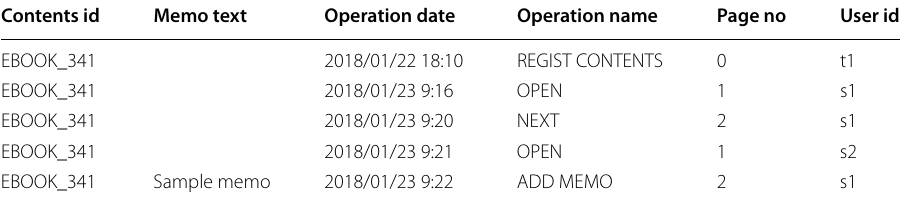
Table 1 A sample of events recorded from user interaction with